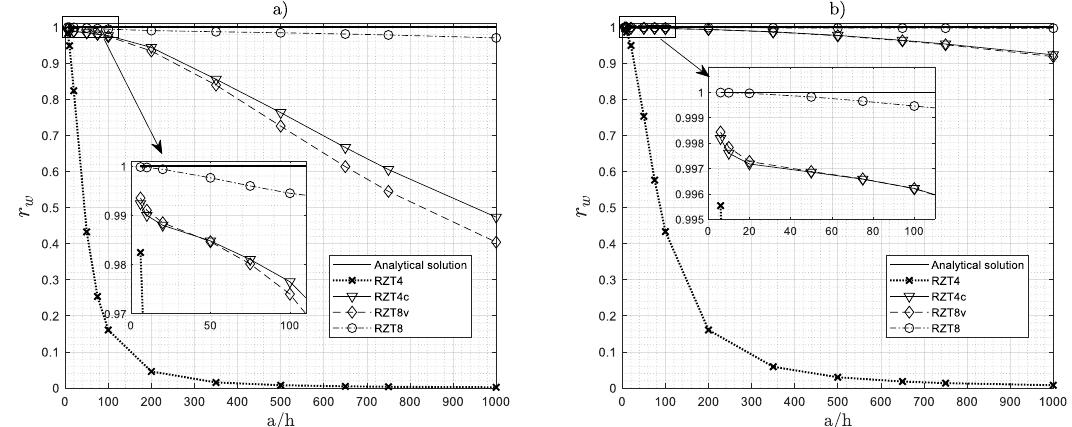
Figure 10. Shear-locking effect analysis. Laminate L, ( a ) mesh 4 × 4, and ( b ) mesh 8 × 8 of a quarter of the plate.